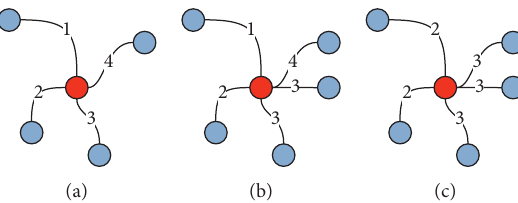
Figure 2: Three scenarios of network percolation. (a) Scenario 1. (b) Scenario 2. (c) Scenario 3.